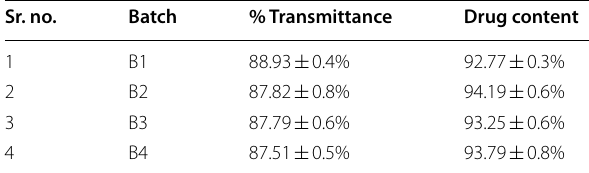
Table 5 Drug content and percent